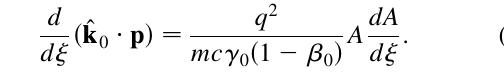
FIG. 1. Geometry of optical pulse incident on an electron traveling in the same